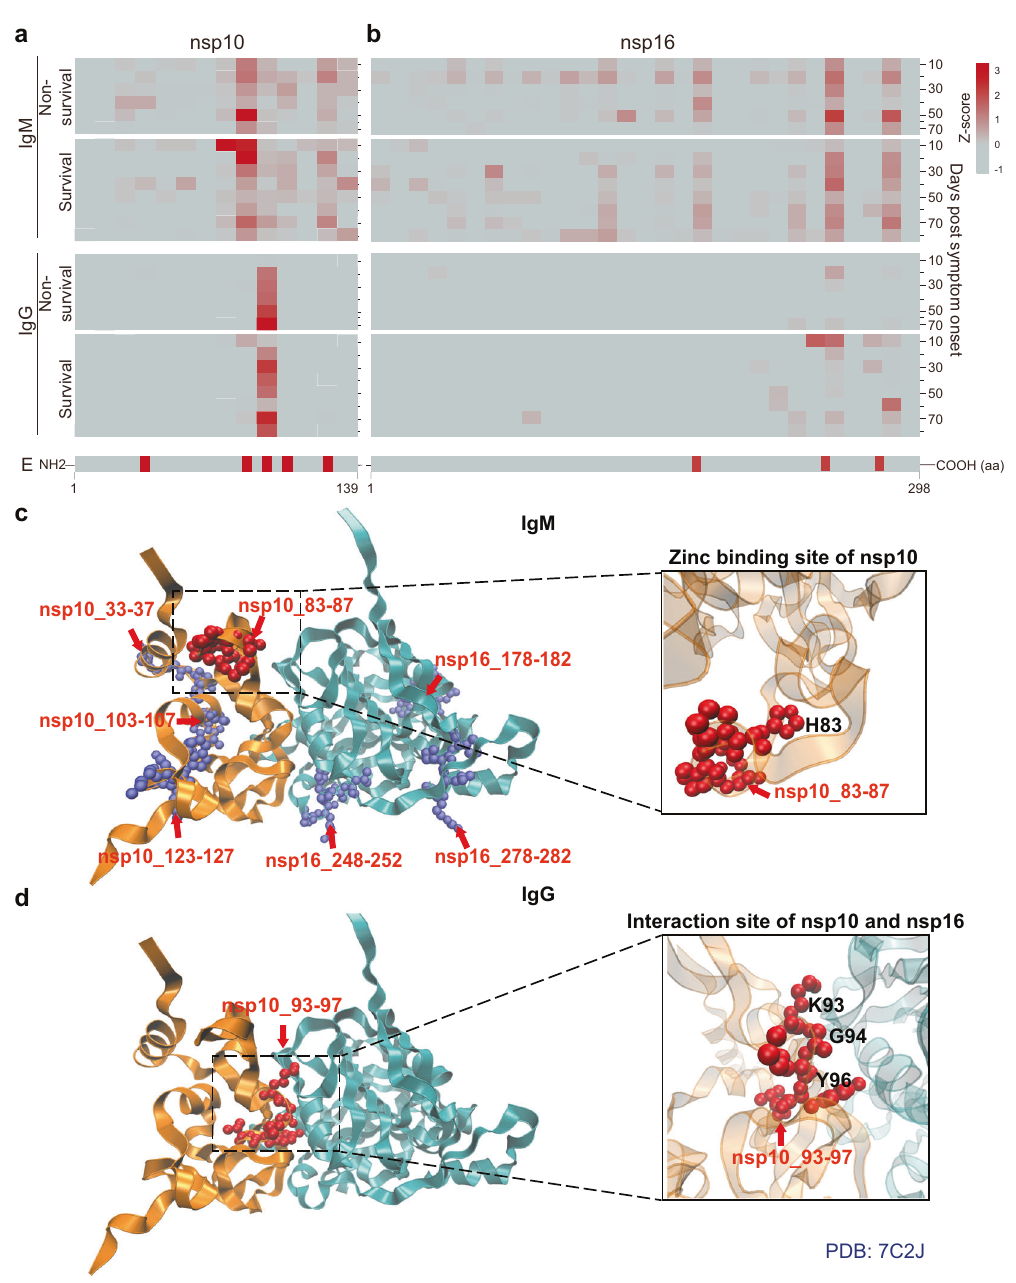
Fig. 6 Dynamic changes of antibody epitopes within the SARS-CoV-2 nsp10/nsp16 2 ′ -O-methylase complex. a , b Longitudinal changes of IgM and IgG antibody epitopes identi fi ed within the nsp10/nsp16 2 ′ -O-methylase complex, respectively. c , d Structural analyses of IgM and IgG epitopes within the nsp10/nsp16 2 ′ -O-methylase complex. The epitopes within the functional domain that may interfere the protein activity are labeled in and accessory (ORF3a, ORF8) proteins (Figs. 2a, d, 3a, b). comprehensively analyzed the humoral immune response to Furthermore, the IgM- and IgG-speci fi c epitopes were different, SARS-CoV-2 in critical COVID-19 patients for the fi rst time at amino demonstrating the different mechanisms used for IgM and IgG acid resolution using a SARS-CoV-2 proteome microarray (Fig. 1a). antibody production (Supplementary Fig. 6a, red arrow). 43 We further determined the association between antibody binding epitopes and COVID-19 survival. Notably, we previously identi fi ed three IgM epitopes (S_816-820, Our data show that the humoral response to the SARS-CoV-2 ORF3a_136-140, N_206-210) and one IgG epitope (S_816-820) as proteome is dynamic (Fig. 2) and target unique epitopes (Fig. 3a). potential early diagnostic biomarkers of COVID-19 infection. 11 The nsps generated from the ORF1ab polyprotein have the largest number of epitopes that are targeted by both IgM (84.7%, 100/ 118) and IgG (58.0%, 40/69) antibodies (Fig. 2d). While the IgM antibodies targeted more epitopes to nsps than IgG antibodies, the IgG antibodies targeted epitopes within the structural (N, S)